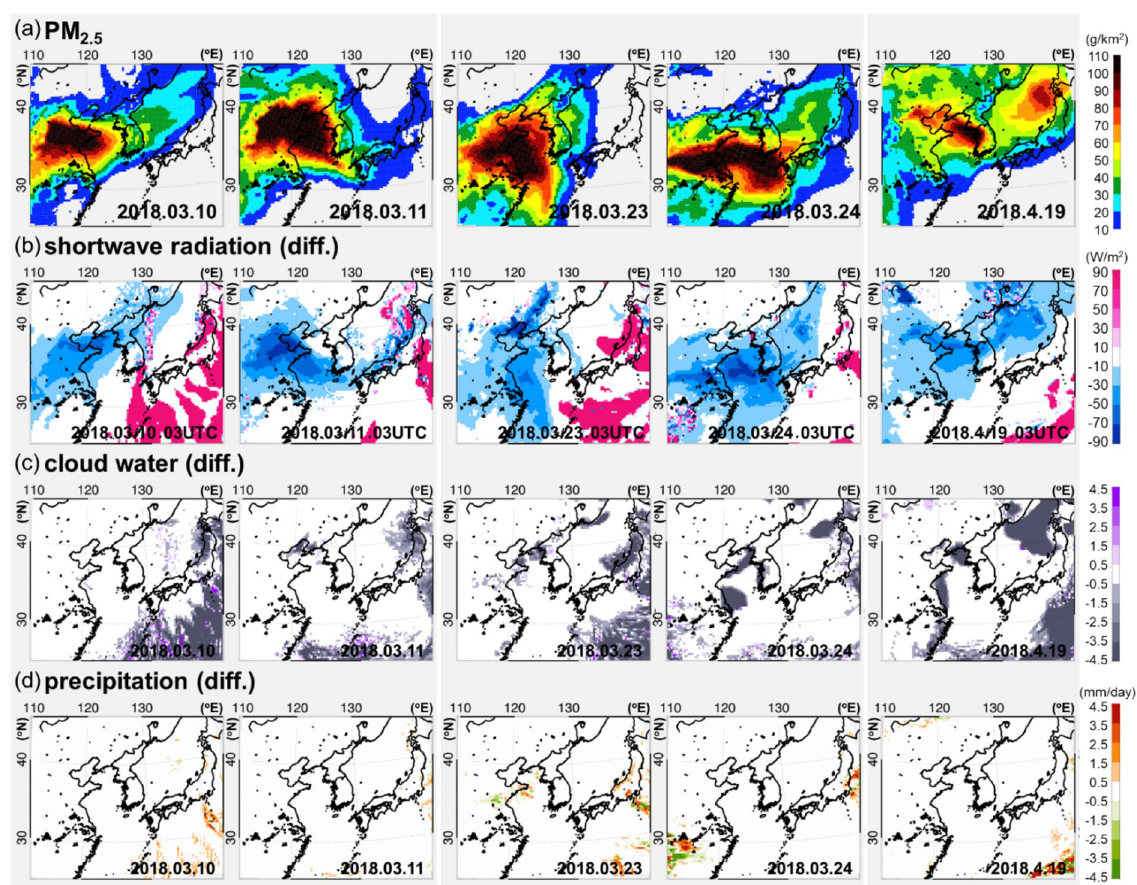
Figure 4. ( a ) Horizontal distributions of vertically integrated PM 2.5 column concentrations during selected high PM 2.5 episodes from March to April 2018. The impact of aerosol-induced differences between online and offline modelling results for ( b ) shortwave radiation at 0300 UTC, ( c ) daily cloud water mixing ratio vertically integrated from the surface to 50 hPa (top of model vertical layers), and ( d ) daily accumulated precipitation amounts for 10, 11, 23, and 24 March 2018 and 19 April